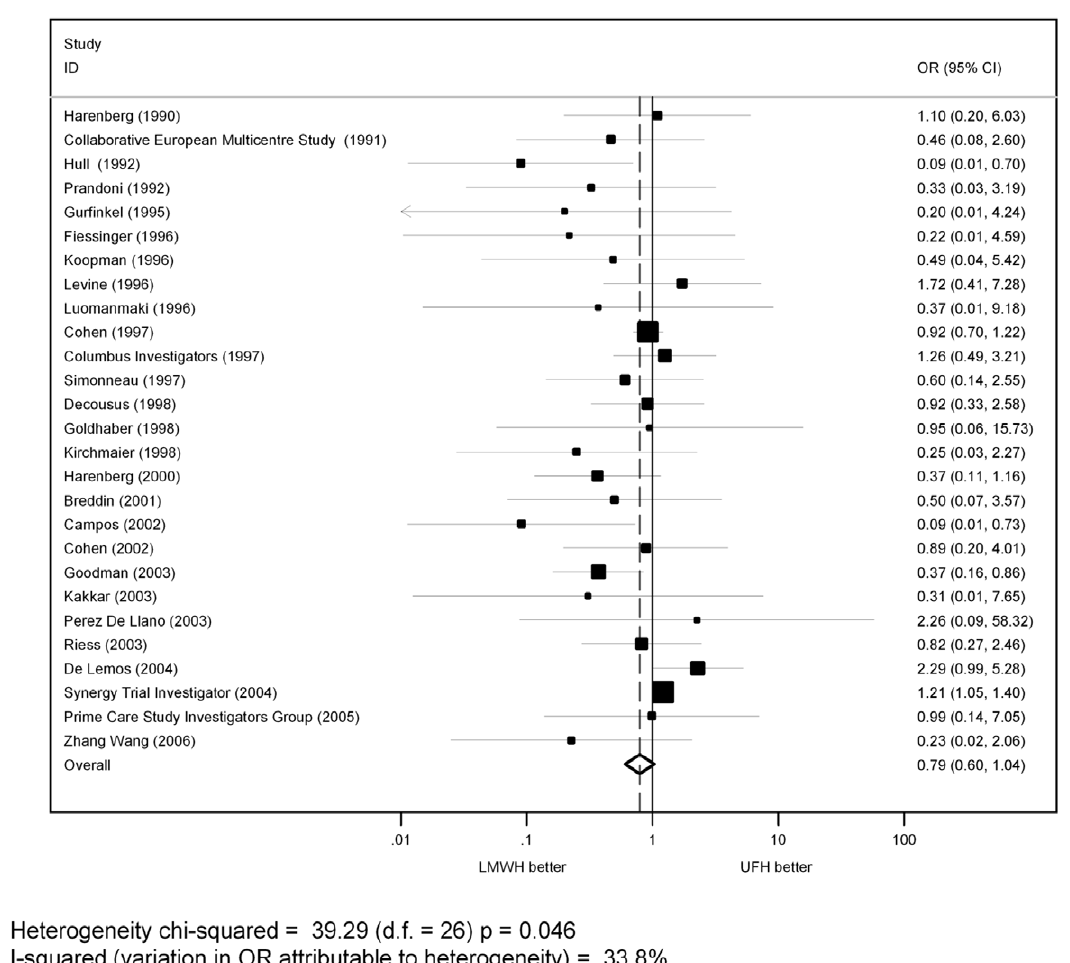
Figure 2. Pooled estimates of OR for major bleedings of LMWH versus UFH in all patients.